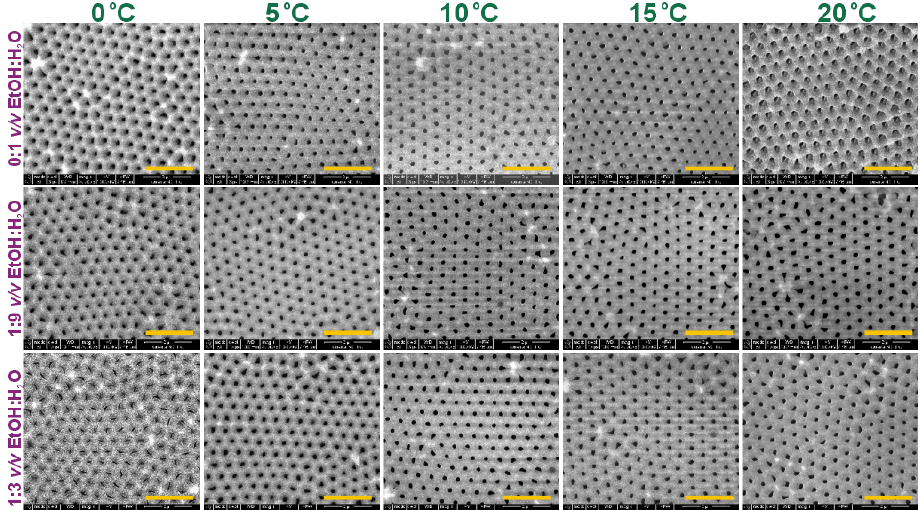
Figure 6. SEM images of porous anodic alumina formed during II anodization performed in 0.3 M etidronic acid solutions without (0:1 v / v EtOH:H 2 O) and with two different amounts of ethanol: 1:9 v / v EtOH:H 2 O and 1:3 v / v EtOH:H 2 O, and in the anodizing temperature between 0–20 °C (the yellow scale bar = 2 µ m).